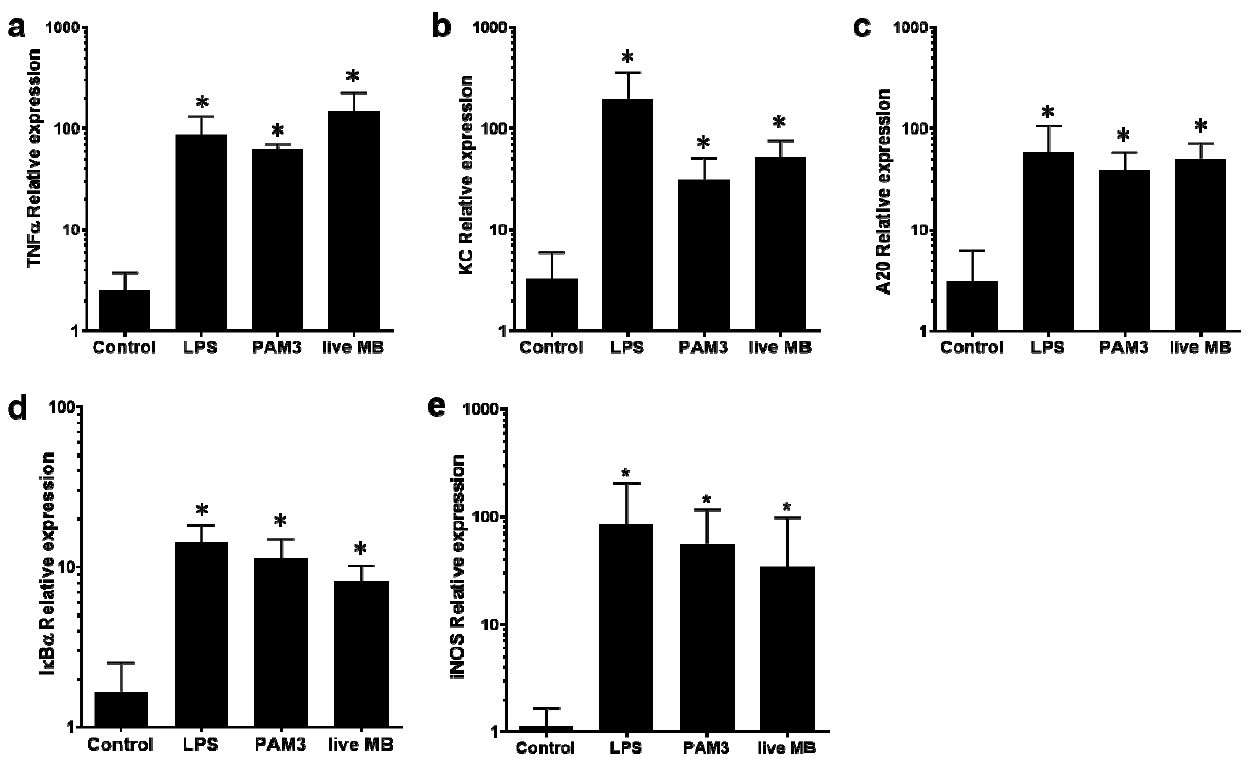
Figure 3. Gene expression of inflammatory mediators in murine mammary glands challenged with live M. bovis , LPS and PAM3. Gene expression was tested 24 h pi following IMM challenge using relative qRT-PCR. Bar graphs (mean and SD) show relative expression of TNF α ( a ), KC ( b ), A20 ( c ), IkB α ( d ) and iNOS ( e ) in control and challenged glands. * Indicates statistical significance in comparison with a control group ( p < 0.05).